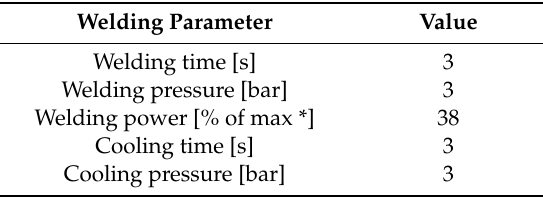
Figure 1. Schematic of high-frequency (HF) welding. Table 2. Applied welding parameters.